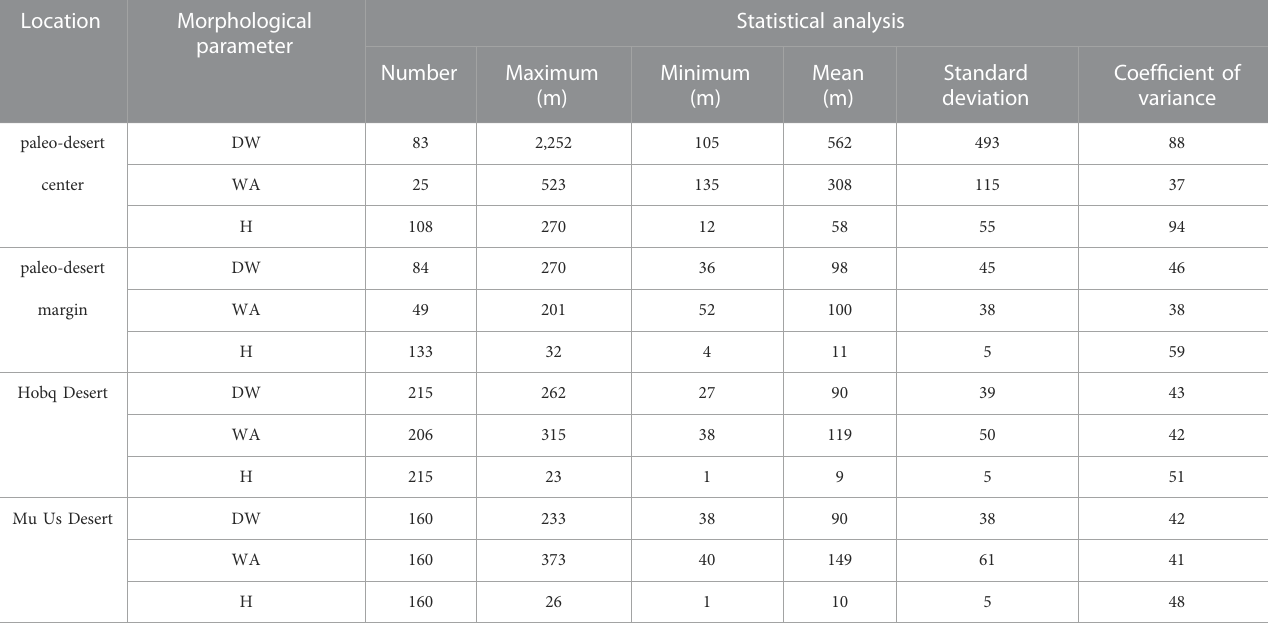
TABLE 2 Results of statistical analysis of wavelength (DW), wave width (WA) and height (H) of both the ancient and modern dunes in the Ordos Basin.